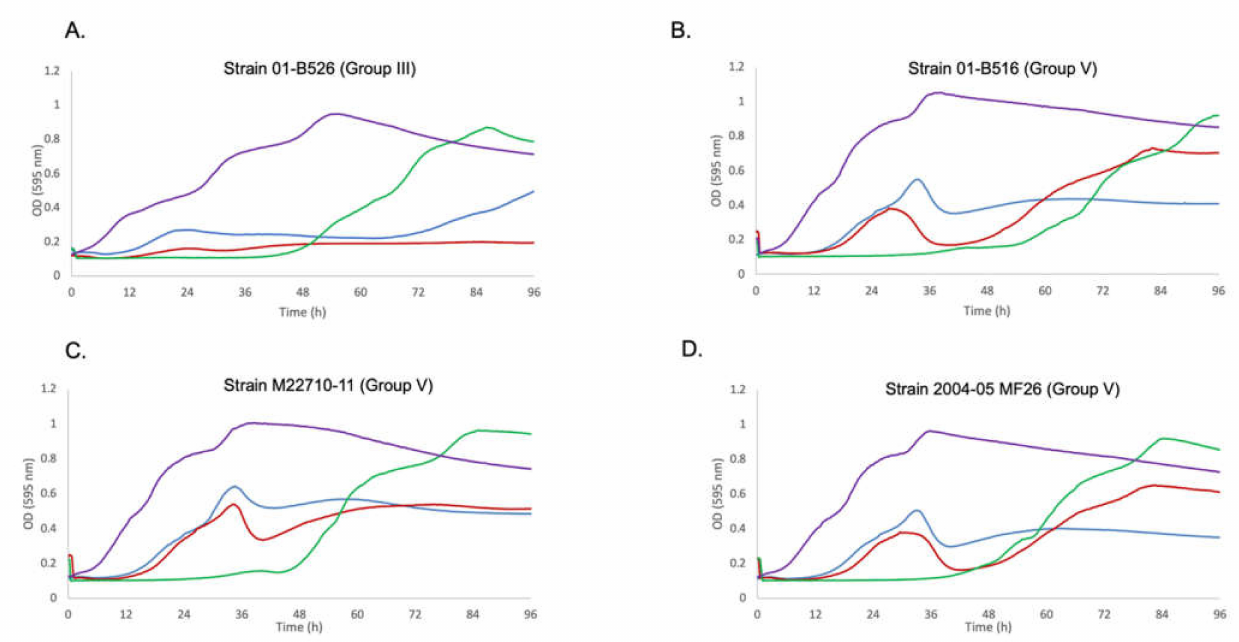
Figure 4. Growth curves for Group III and V strains against Cocktail T. ( A ). Growth curve of strain 01-B526 (Group III) is shown. The purple curve is the bacterium alone. The blue, red and green curves are the growth of the bacterial strain with Cocktail T at MOIs 0.1, 1, and 10, respectively. The same color code of the curves applies to all panels of this figure. Here, the highest bacteria growth inhibition is for MOI 1. Bacterial growth can be seen for MOI 10 after 48 h. ( B – D ). Growth curves of strains 01-B516, M22710-11, and 2004-05 MF26, respectively (Group V). These strains bear AsaGEI2a and Prophage 3. The ineffectiveness of the cocktail due to the presence of Prophage 3 can be observed during the logarithmic phase in case of MOIs 0.1 and